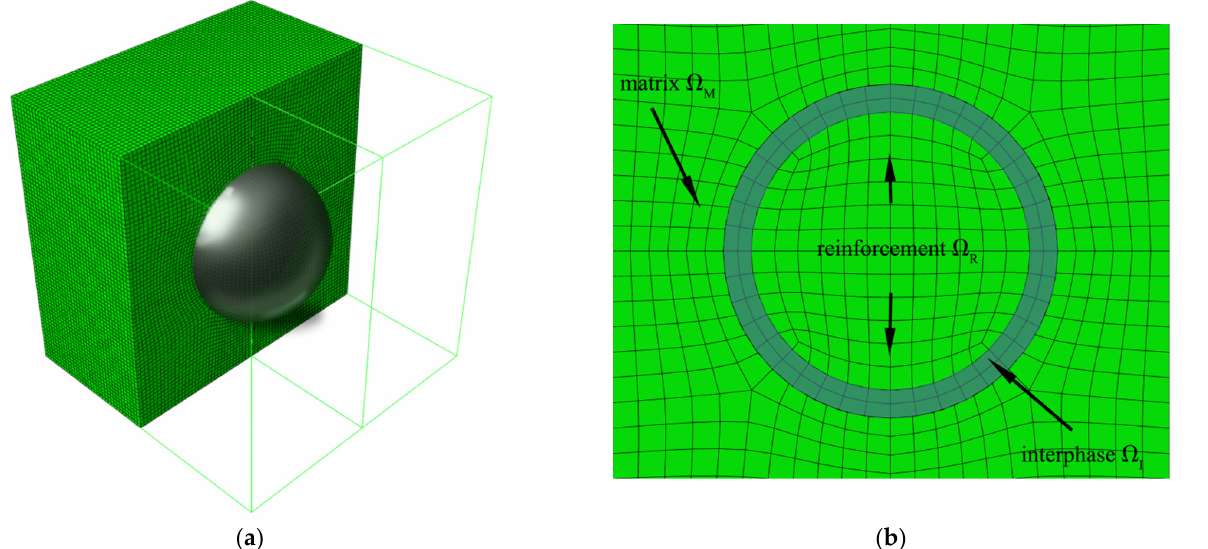
Figure 1. View ( a ) and cross-section ( b ) of the RVE.